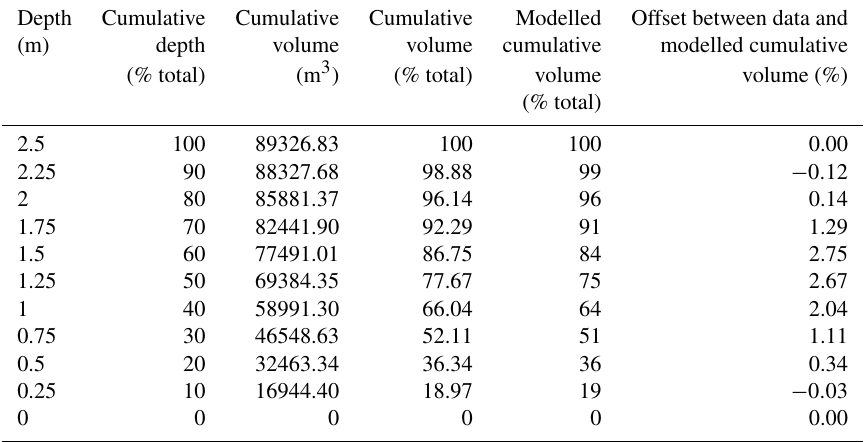
Table D1. Big Bear Lake bathymetric data and fit between the modelled relationship between lake volume and lake depth as a percentage of total lake volume and depth. Depth Cumulative Cumulative Cumulative Modelled Offset between data and depth volume volume cumulative modelled cumulative